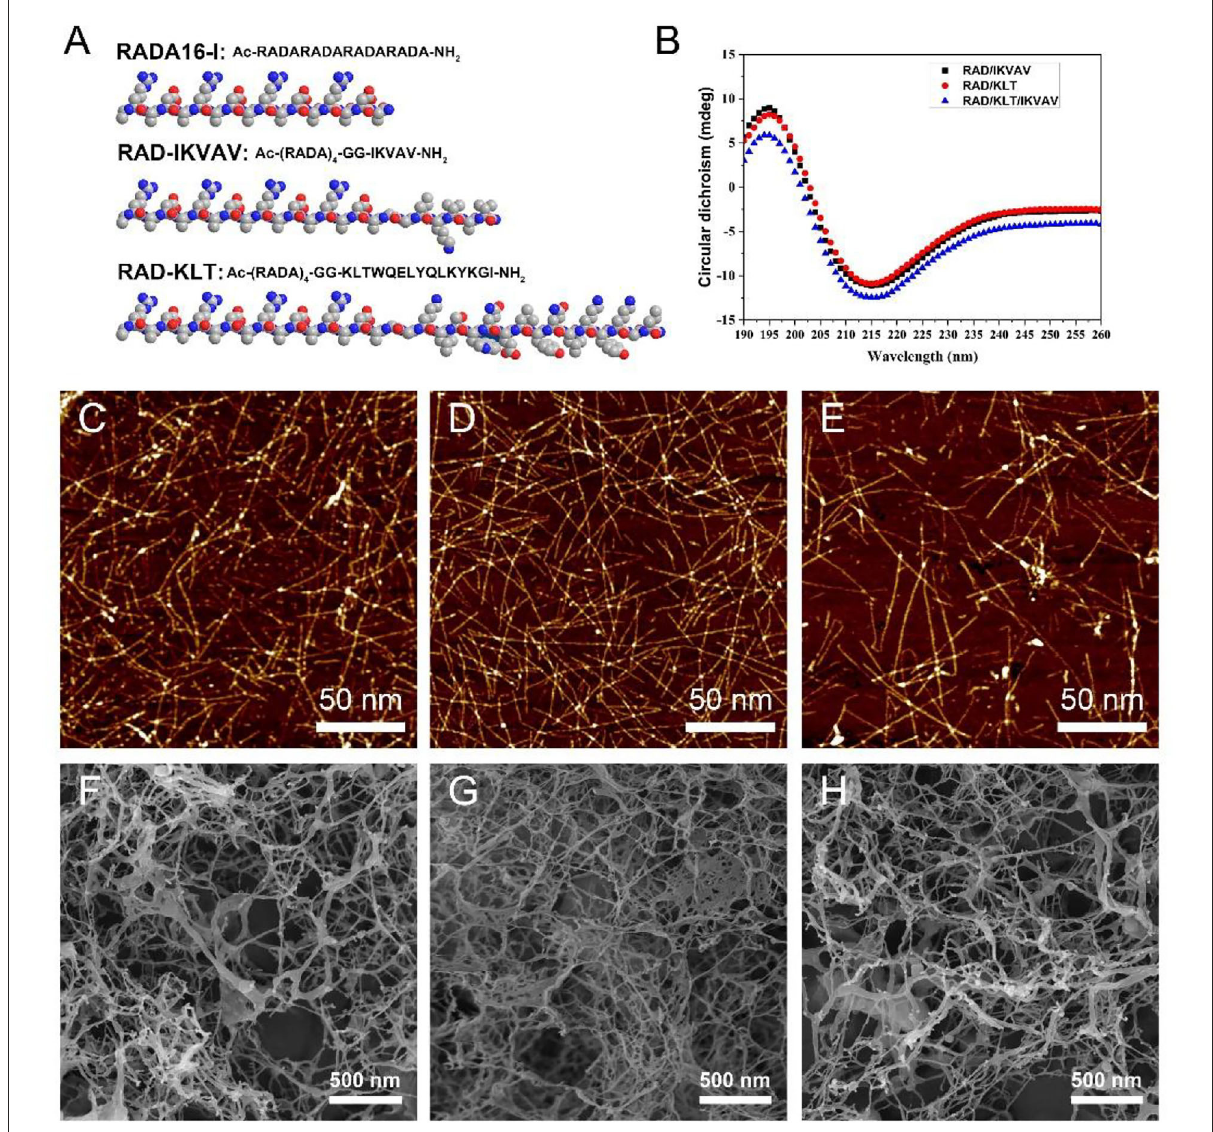
FIGURE1 (A) The chemical structure and space-filling model of RADA16-I and the functional SAP RAD-IKVAV and RAD-KLT. (B) CD spectra of different SAPs mixtures RAD/KLT, RAD/IKVAV and RAD/KLT/IKVAV. The AFM images of RAD/KLT. (C) , RAD/IKVAV (D) , and RAD/KLT/IKVAV (E) . The SEM images of RAD/KLT (F) , RAD/IKVAV (G) , and RAD/KLT/IKVAV (H) .